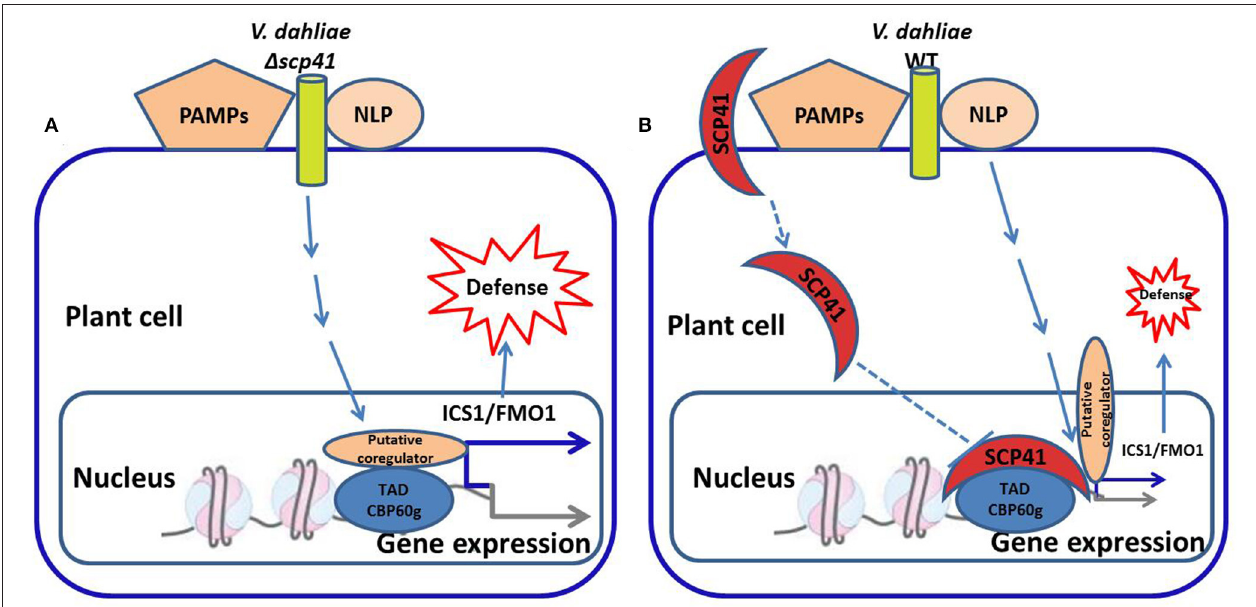
FIGURE 2 | Model for VdSCP41-mediated suppression of Arabidopsis defense during Verticillium dahliae infection (Qin et al., 2018; Zhang et al., 2018). (A) During the infection of V. dahliae , the plant transcription factor CBP60g induces the expression of immune-related genes and the defense response. (B) VdSCP41, a V. dahliae effector protein, is transported to the nucleus of plant cells and directly targets CBP60g, which interferes with the transcription factor activity and thus suppresses plant immunity. WT, wildtype, PAMPs, pathogen-associated molecular patterns, NLP, nuclear localization protein, SCP41, secretory protein 41, ICS1, isochoric acid synthase 1, FMO1, flavin monooxygenase 1, TAD, transcription activation domain, CBP60g, calmodulin binding protein